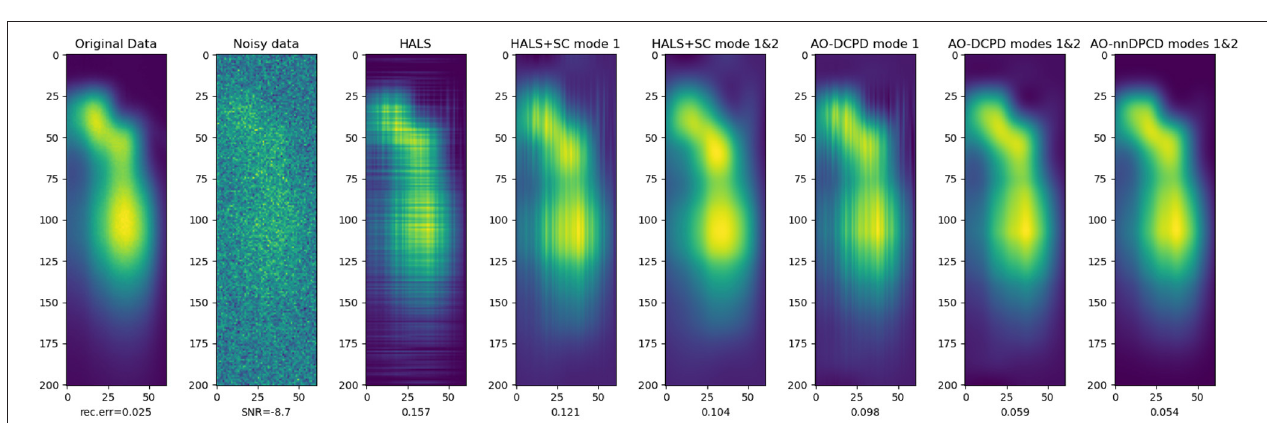
FIGURE 5 | The fourth slice (index 3 if counting from 0) of the reconstructed tensors, see Figure 4 for details on each method. Row index relates to the emission wavelength while the column index relates to the excitation wavelength. The bottom values indicate the relative reconstruction error with respect to the clean tensor.